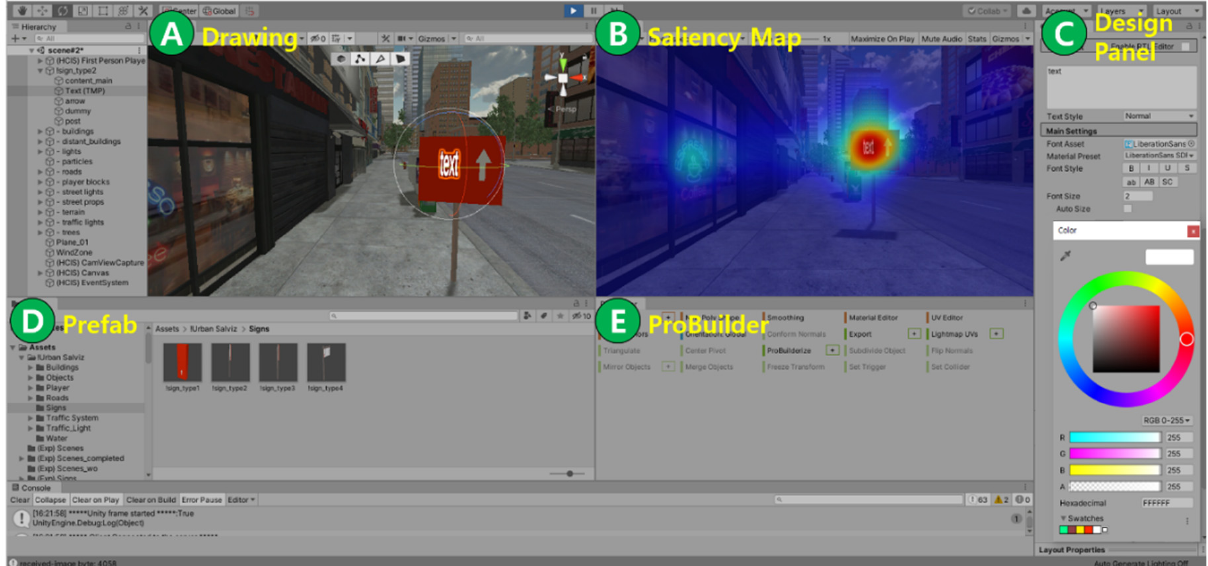
Figure 3. Interface outline of our urban design tool, which is based on Unity 3D and allows users to create 3D urban elements either from a half-made model ( D ) or from scratch ( E ) and fine-tune the design elements ( C ). Users can simulate the location, orientation, and size of the designed object ( A ) while checking a virtual pedestrian’s viewpoint or visual attention ( B